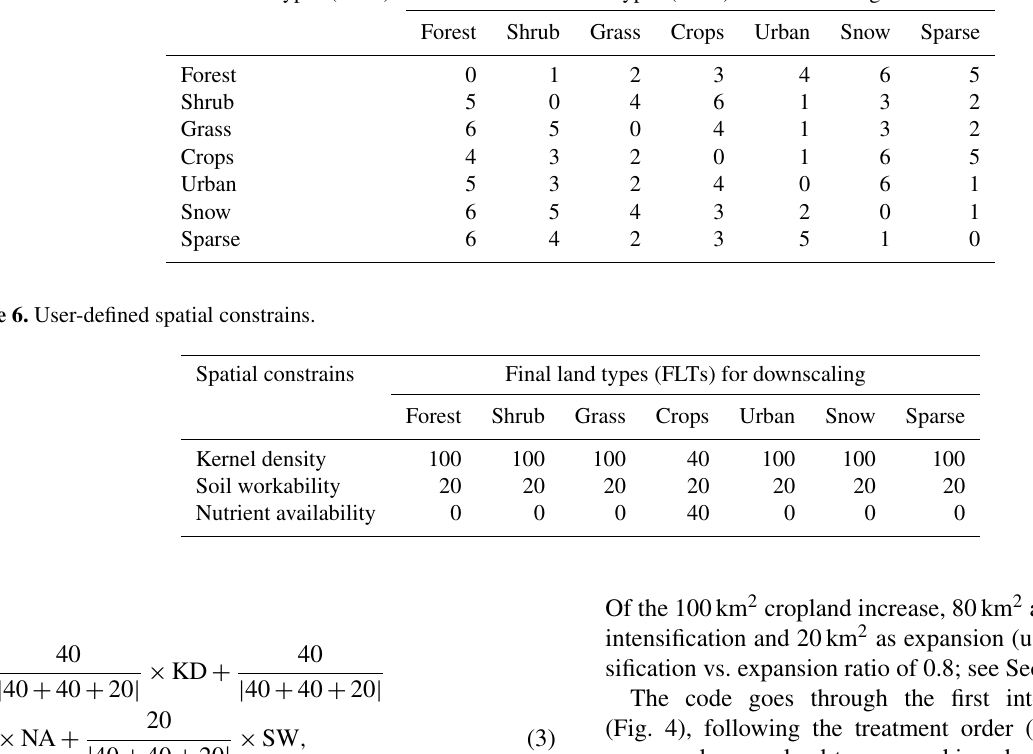
Table 5. User-defined transition priorities. Final land types (FLTs)